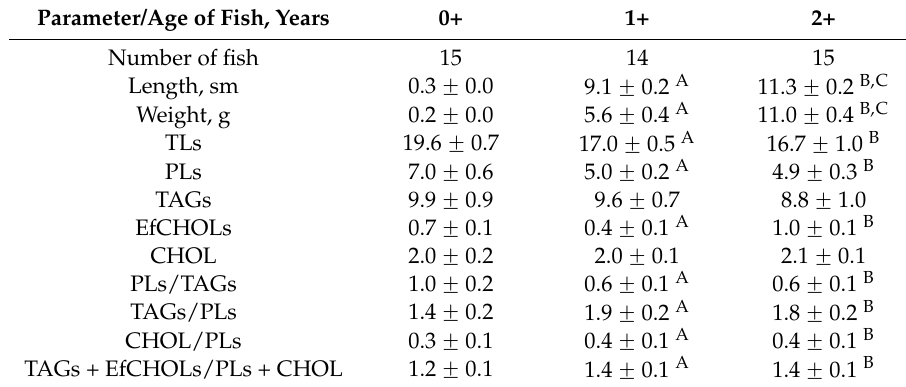
Table 1. Total lipids and lipid classes (% dry weight) of juvenile Atlantic salmon at different ages (0+, 1+, and 2+ years) in the Sobachji shoal (the Varzuga River). Data are presented as average ˘ SD (standard